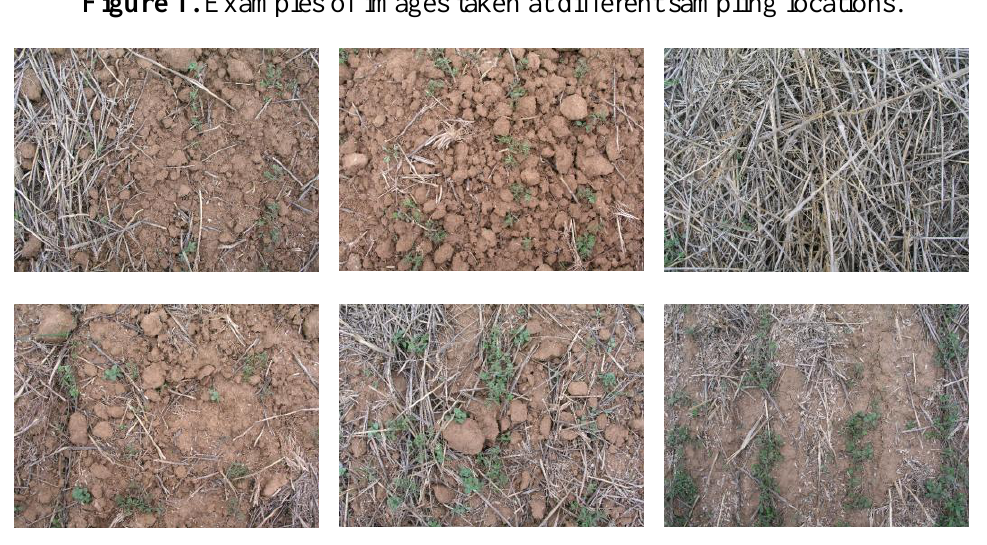
Figure 1. Examples of images taken at different sampling